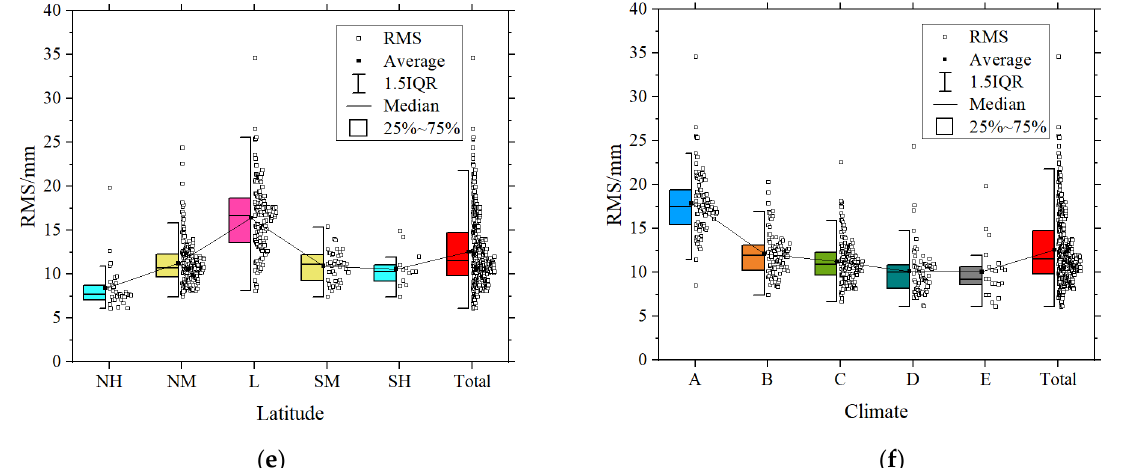
Figure 10. ERA5 errors semi-box line plots for latitude ( a , c , e) and climate ( b , d , f ) classification. As the latitude decreased, all errors in the inverted ZTD of the ERA5 reanalysis data increased significantly. The mean bias, MAE, and RMS in the low-latitude region increased by approximately 38.5%, 23.6%, and 23.4%, respectively, compared with the global average, with approximately 61.9%, 32.5%, and 31.8% increasing, respectively, in the mid-latitude region, and stations in the high-latitude region increasing by approximately 20.6%, 42.9%, and 45.0%. The mean error for the middle and high latitudes was lower than the global mean, except in the southern high-latitude region, indicating that station errors at low latitudes dominated the global error distribution. For the climatic distribution of errors, the stations in the tropical zone had significantly larger errors, with the mean bias, MAE, and RMS errors increasing by approximately 42.8%, 30.2%, and 29.8%, respectively, compared to the global average, and even increasing by approximately 6.9%, 8.6%, and 8.3% compared to the stations in the lower latitudes, indicating that the main errors in the inversion of ZTD using reanalysis data originated from the tropical zone at low latitudes.